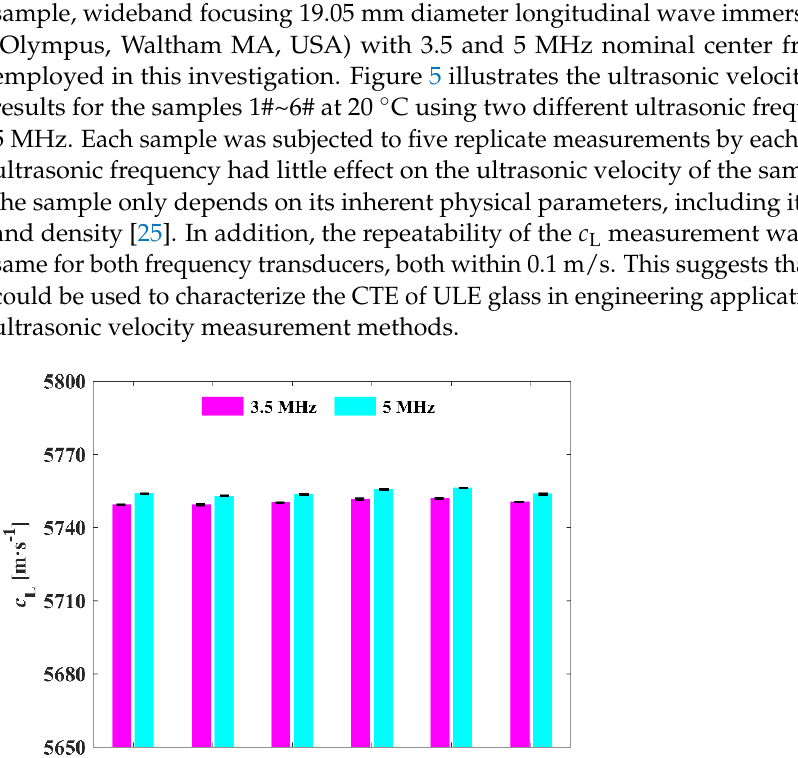
Figure 4. Schematic diagram of the experimental system for measuring ultrasonic velocity.